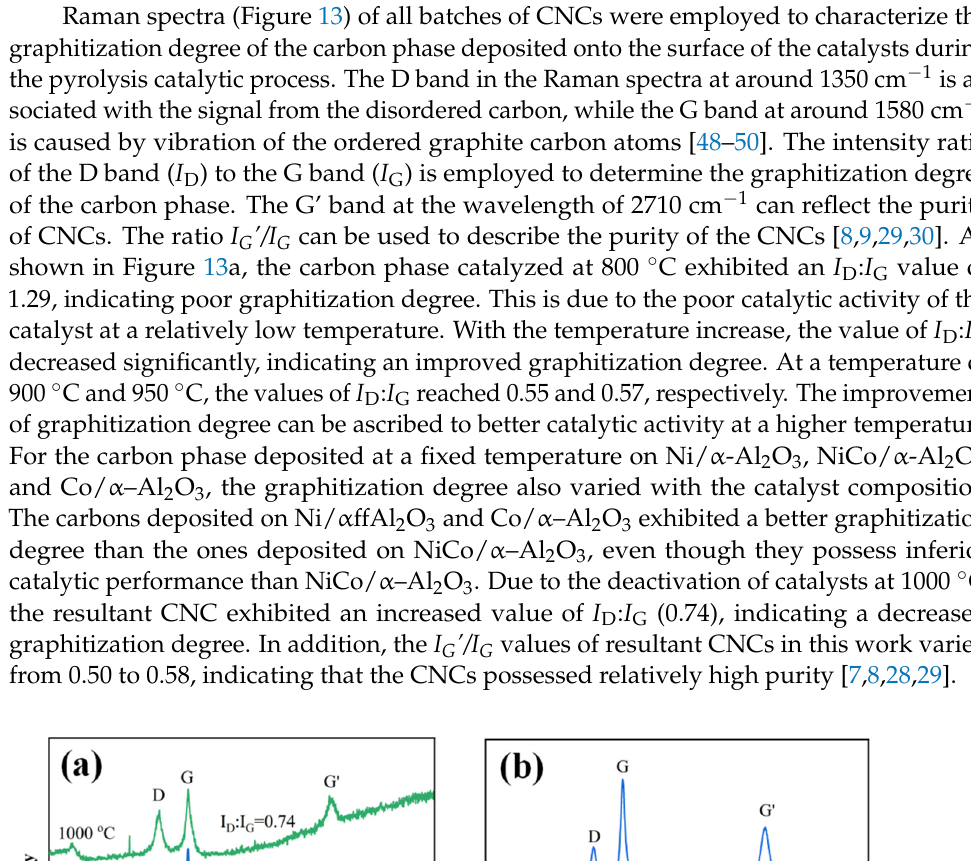
Figure 12. Temperature programmed oxidation ( a ) and DTA (exothermal in the negative direction) plots of CNCs synthesized at different temperatures with the NiCo/ α –Al 2 O 3 catalyst ( b ).